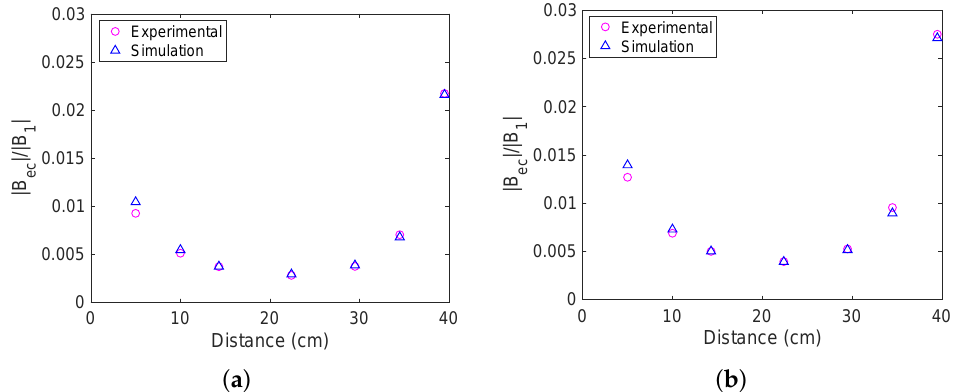
Figure 8. Detected magnetic field ratio as the distance from the excitation coil to the object is varied at 500 Hz for ( a ) the solid aluminium cylinder and ( b ) the solid steel cylinder.